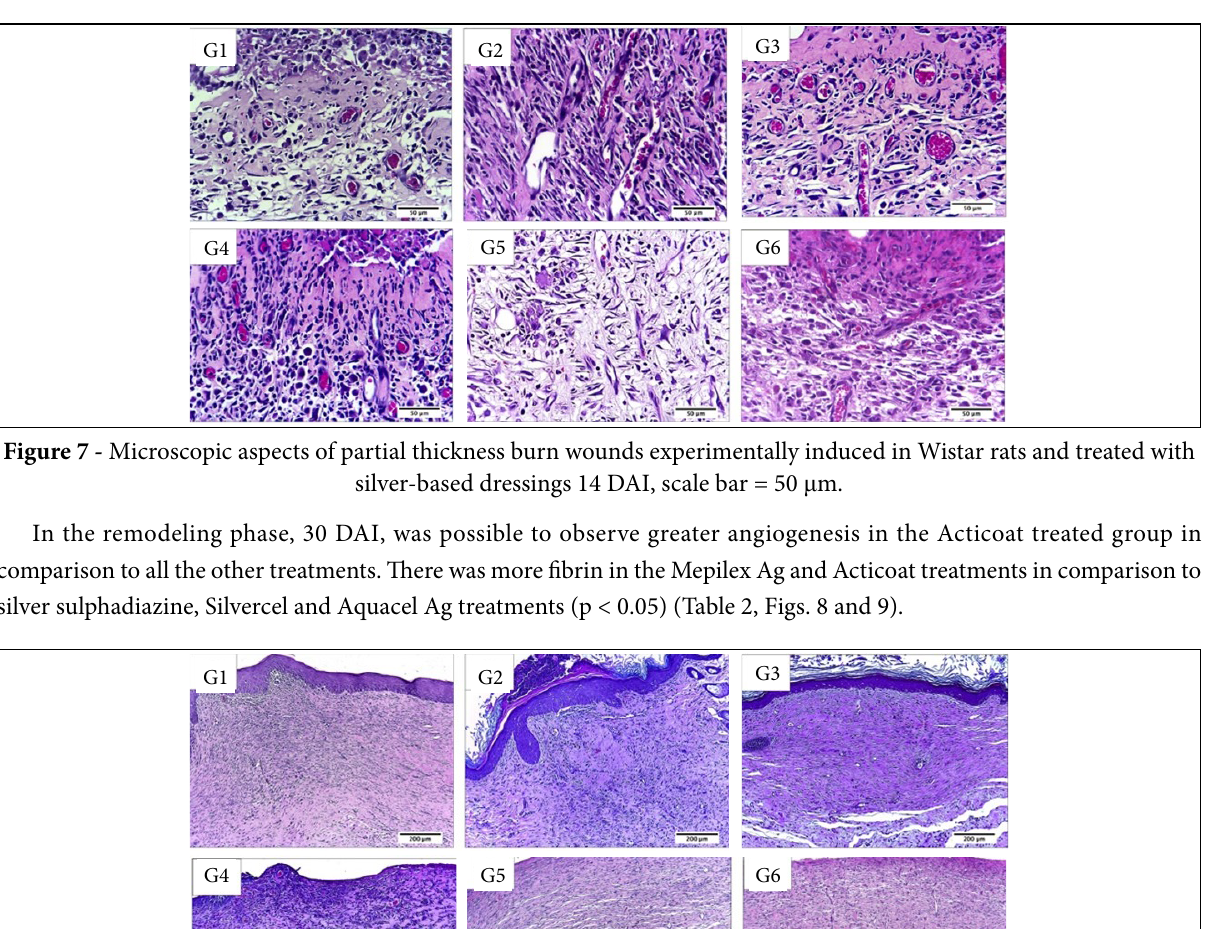
Figure 6 - Microscopic aspects of partial thickness burn wounds experimentally induced in Wistar rats and treated with silver-based dressings 14 DAI, scale bar = 200 μ m.